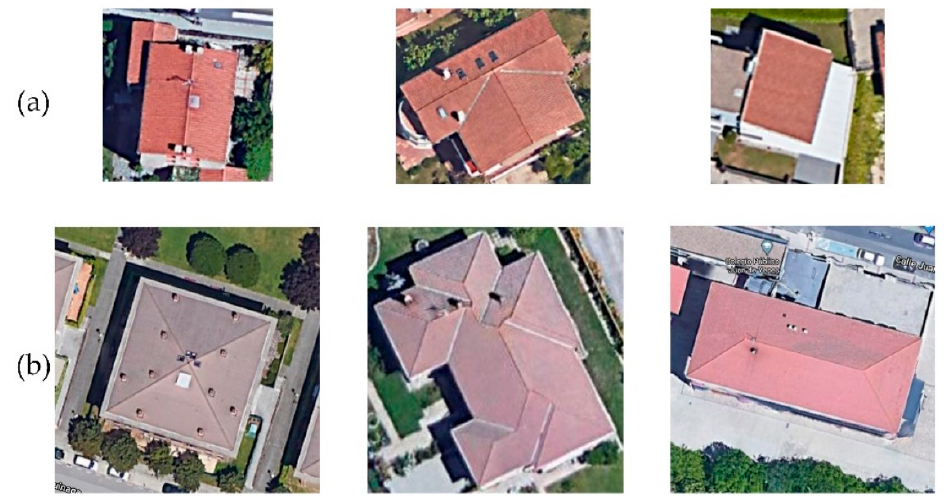
Table 5. Main features of the second coverage LiDAR data. Figure 6. Example of residential building roofs used for the evaluation of the effect of the point cloud density in the surface computation error: ( a ) <200 m 2 , ( b ) >200 m 2 .